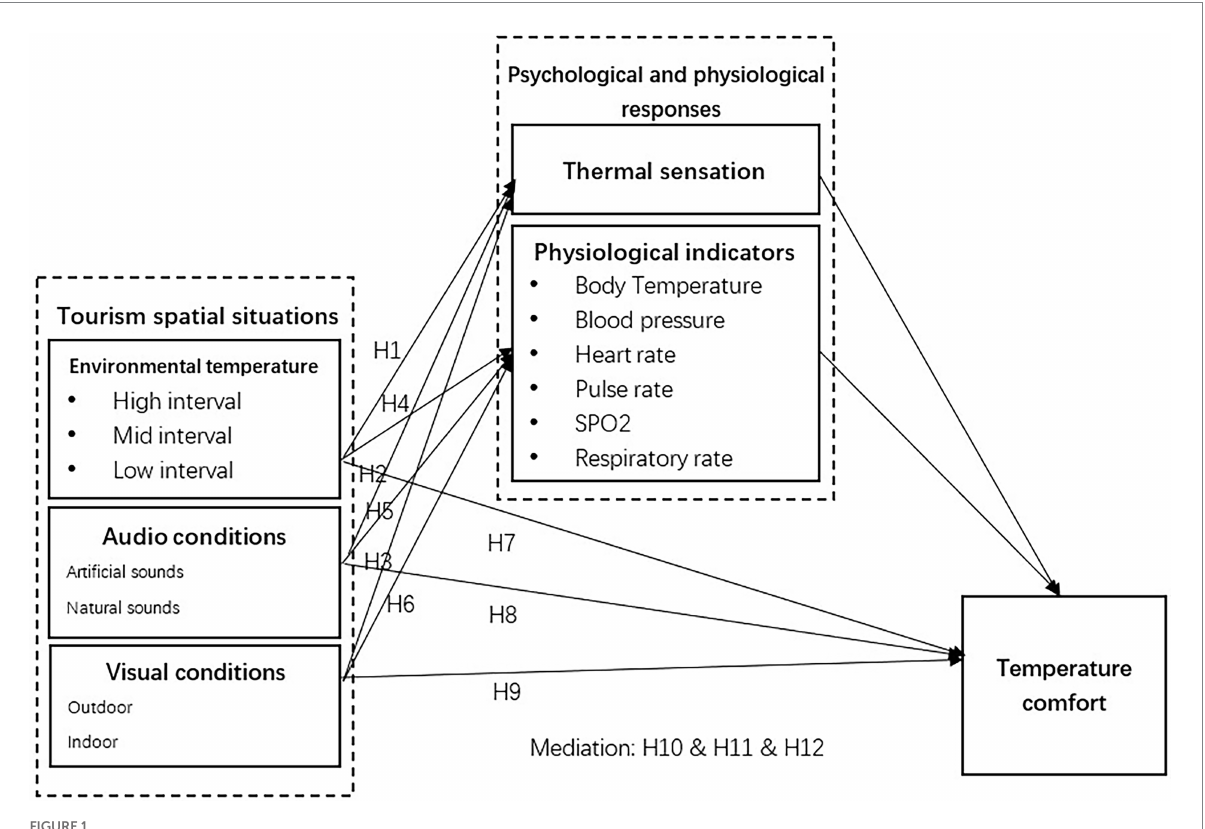
FIGURE 1 Theoretical model.